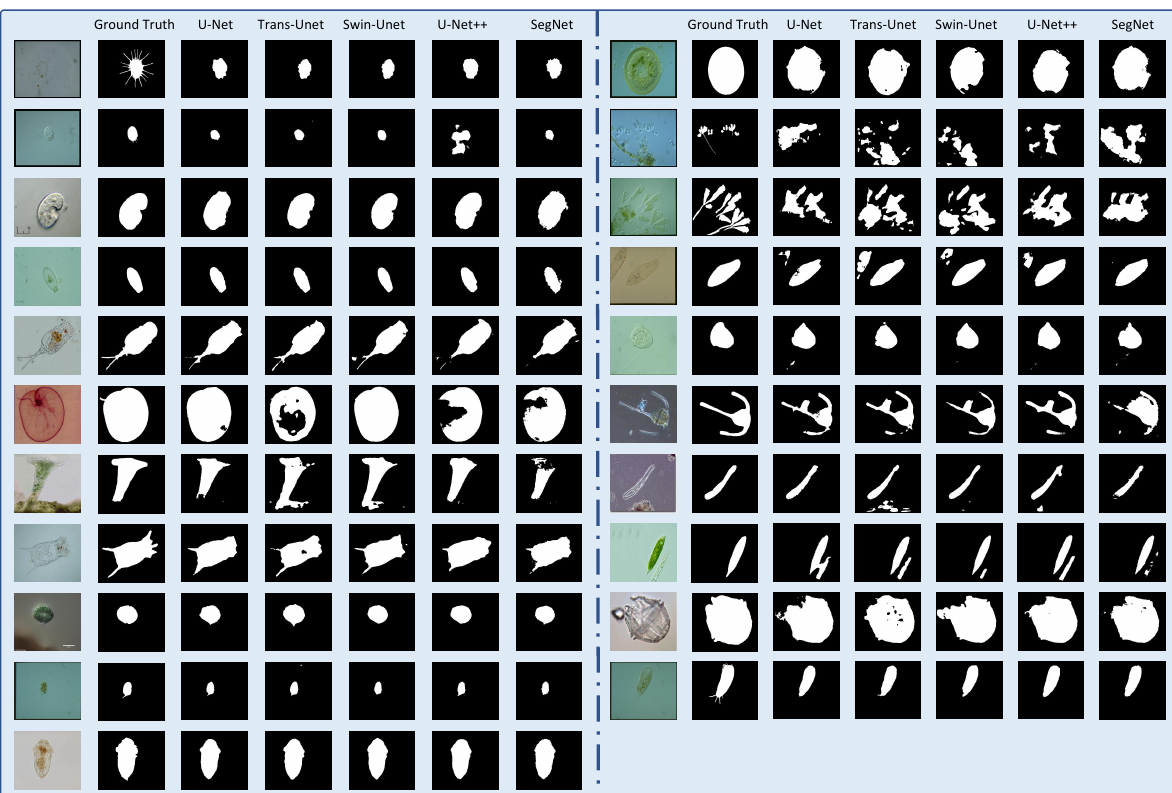
Figure 8. Reconstruction of pixel-level segmentation results on transparent images of the test set. (The figure contains the original image, ground truth image and U-net, Trans-Unet, Swin-Unet, U-Net++, and SegNet network model predicted segmentation results).